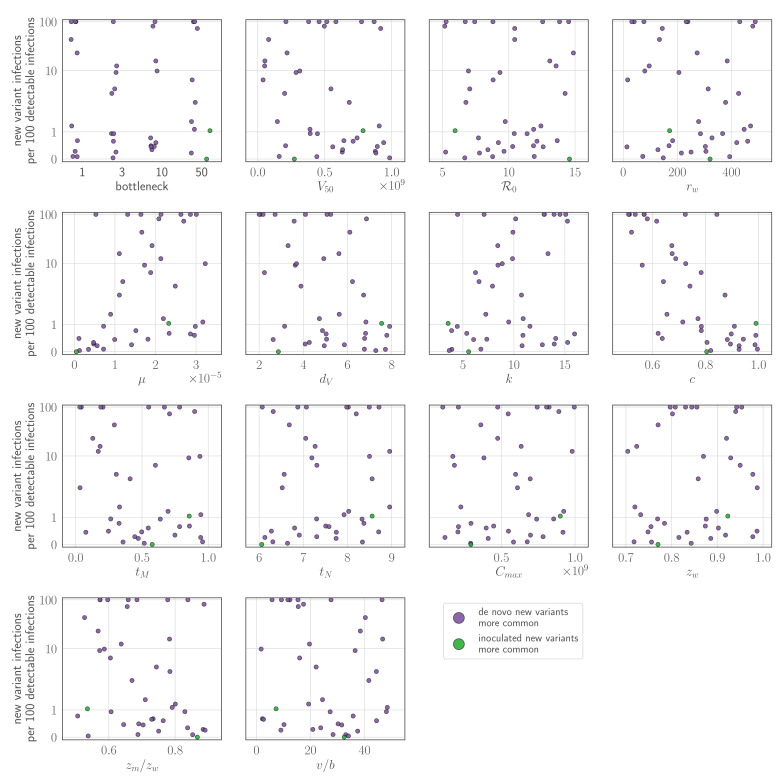
Sensitivity analysis: parameter values versus rate of new variant infections per 100 detectable infections of an experienced host, given an unrealistically early recall response.Parameters randomly varied across the ranges given in Table 2, with tM varied between 0 and 1. Each point represents a parameter set; the rate of new variant infections per hundred 100 detectable infections is estimated from 50,000 simulated inoculations of an experienced host. A new variant infection is defined as one in which the new variant reached a transmissible frequency of at least 1% at any point in the infection. Points are colored according to whether new variant infections were more frequently caused by de novo generated (purple) or inoculated (green) new variant viruses.